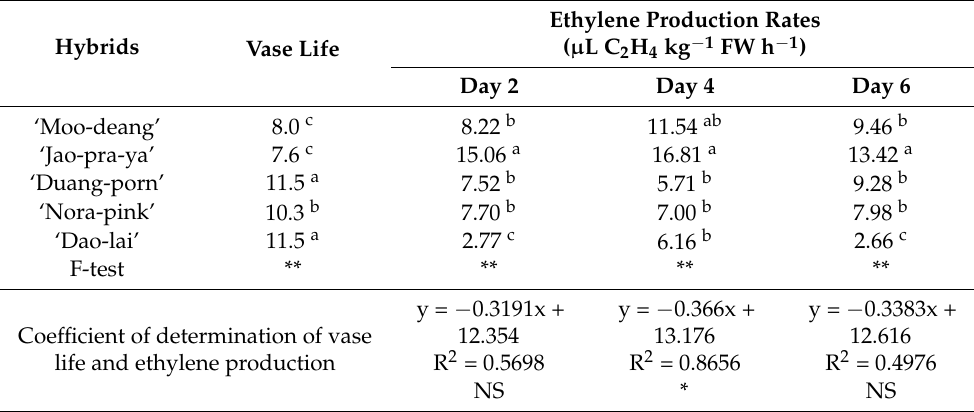
Table 1. Correlation of vase life and ethylene production rates during the initial six incubation days of cut inflorescences of five Mokara orchid hybrids. The inflorescences were incubated in distilled water in the observation room throughout the experimental period. The results represent means of 8–10 replicates ± SE. Different letters represent significant differences at p ≤ 0.01 according to DMRT test. *, ** indicate significant differences at p ≤ 0.05 and p ≤ 0.01, respectively according to linear regression; the higher R-Squared value the better (>0.70). NS, not significant.